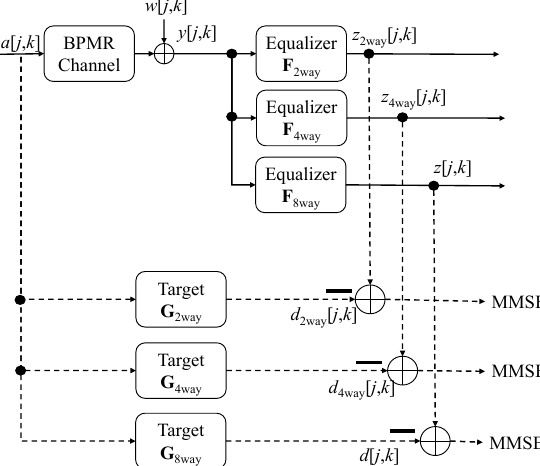
Figure 7. Training model for calculating the coefficients of the equalizer and target.